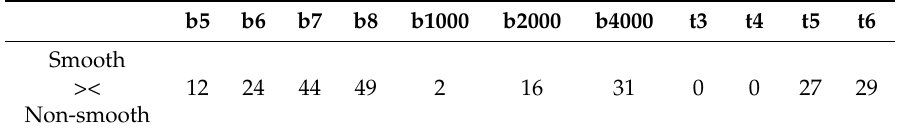
Table 12. Significant difference scores (%) between the smooth/non-smooth parameter (field